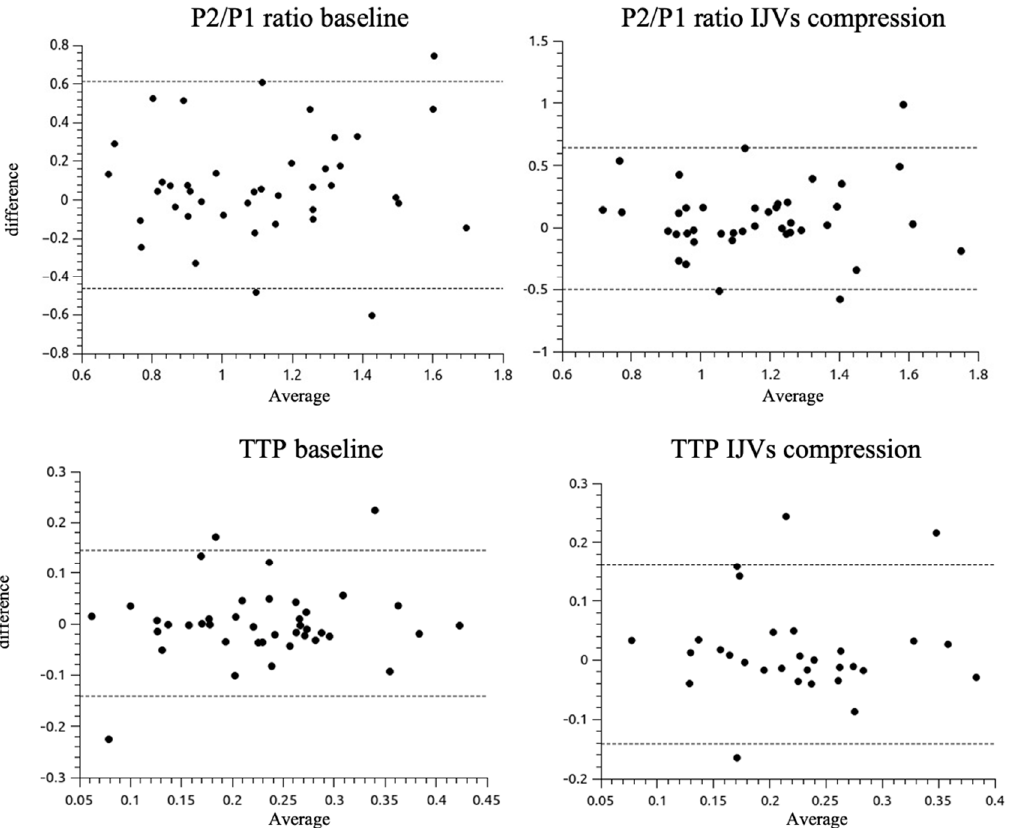
Figure 4. Bland-Altman plots for P2/P1 ratio (up, values from 0.6 up to 1.8) and TTP (down, values from 0.05 up to 0.45) features from ICP and B4C waveform morphologies at the baseline and IJVs compression intervals. The dashed lines represent the 95% limits of agreement (standard deviation 1.96). IJVs: internal jugular veins, TTP: time to peak.